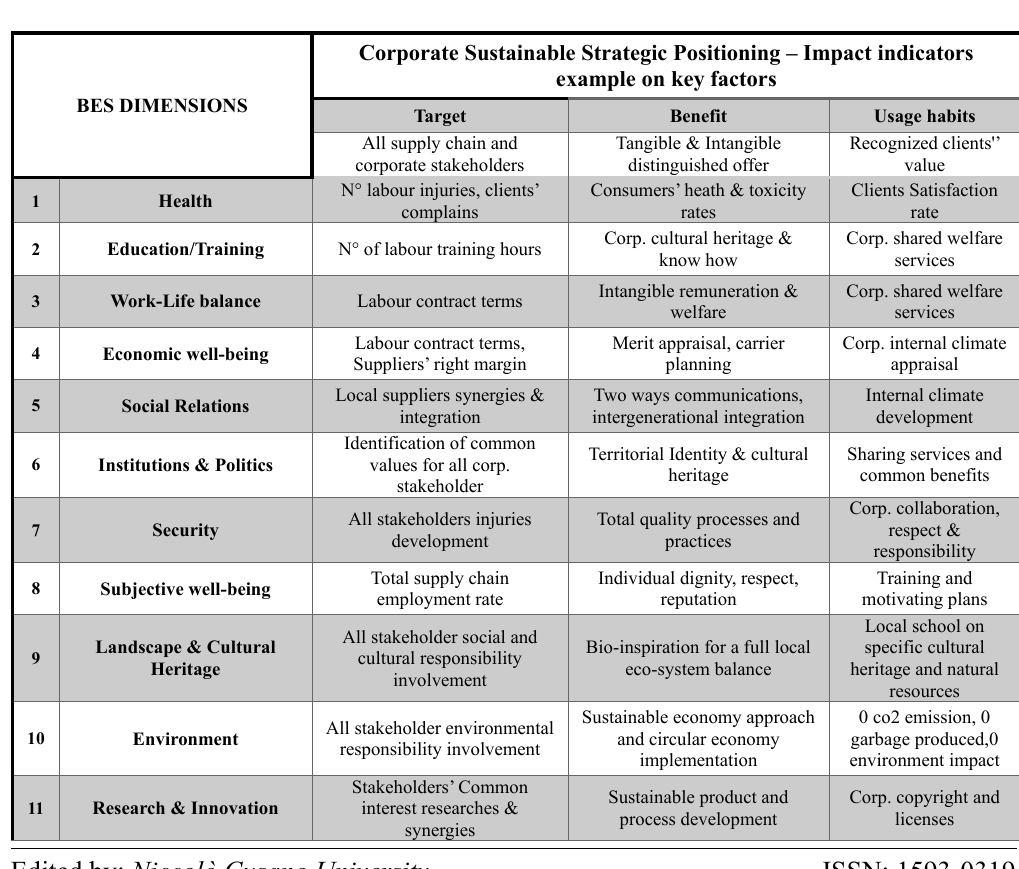
Table 3: The BES Strategic Cross Impact Matrix